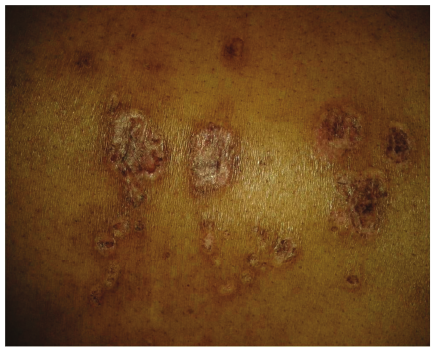
Figure 3: CT angiography showing near total stenosis of the proximal part of left subclavian artery and luminal obstruction of left common carotid artery and more than 50% stenosis of 3rd part of the right subclavian